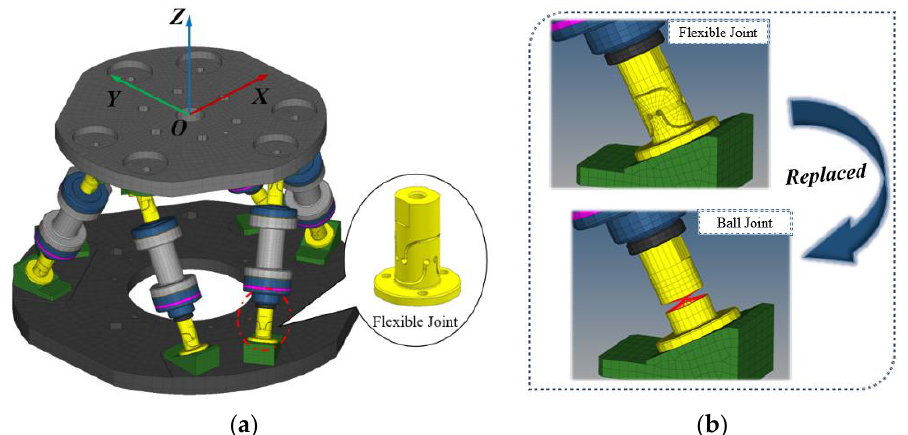
Figure 2. FEM model of the Stewart platform. ( a ) FEM of Stewart platform with flexible joints; ( b ) Equivalent finite element modeling of ball joint.